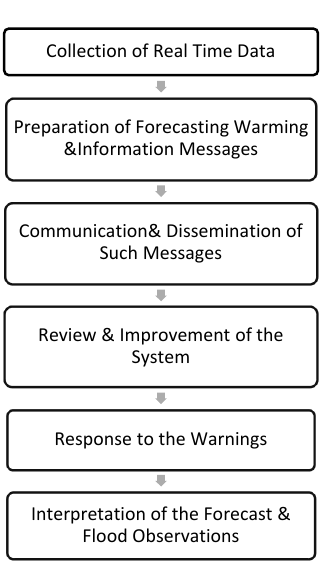
Figure 1. Components of the Flood Forecasting and Warning System.